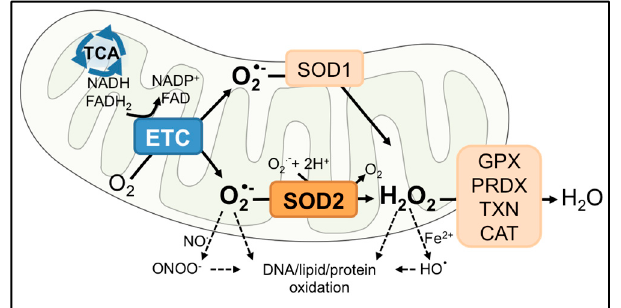
Figure 1. Function of mitochondrial SOD2. SOD2 is localized in the mitochondrial matrix to catalyze